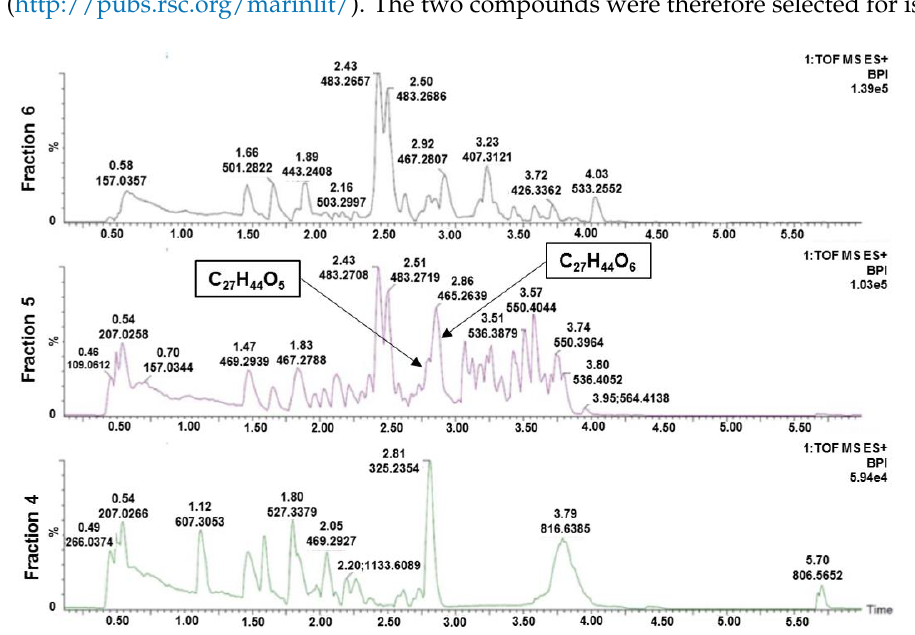
Figure 2. Chromatograms of the active fraction 5, and the inactive fractions 4 and 6, analyzed